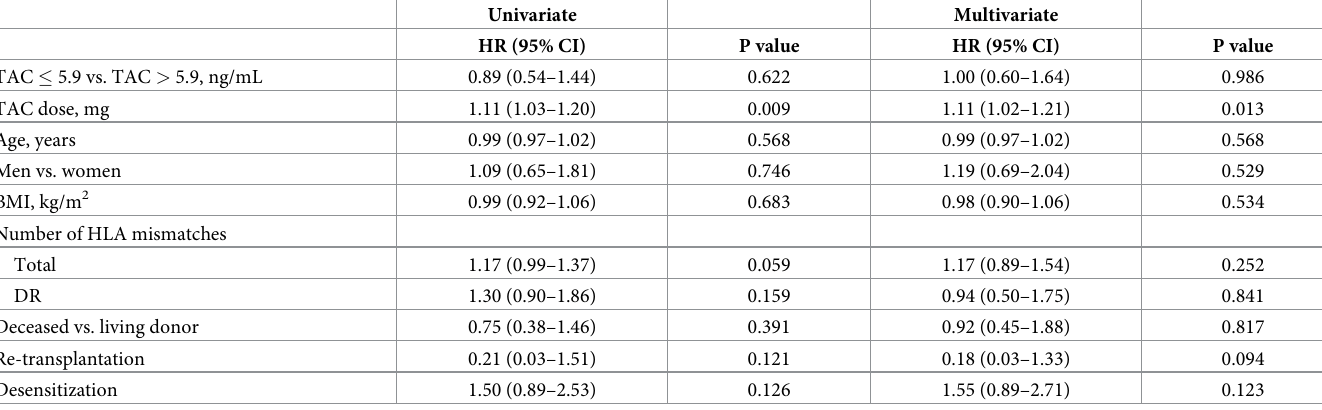
Table 5. Univariate and multivariate Cox regression analysis for opportunistic